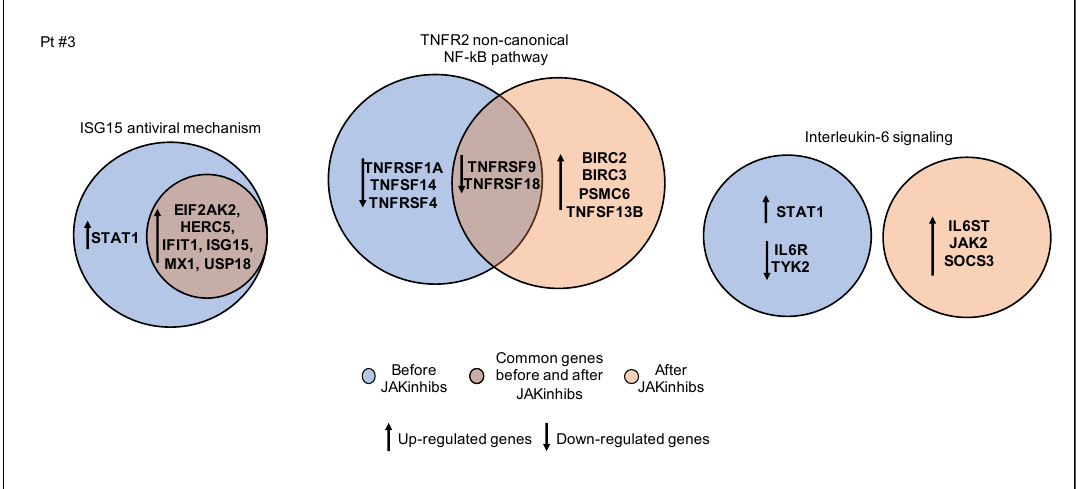
Figure 5. Pathway enrichment analysis before and after JAKinhibs treatment. Pt,